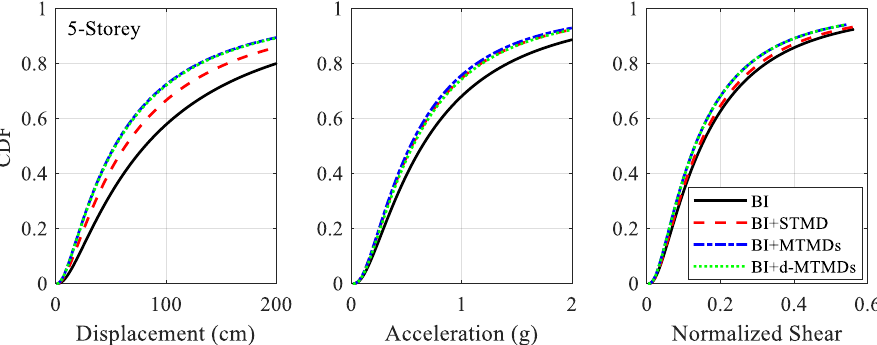
Figure 7. Cumulative probability distribution functions of maximum bearing displacement, peak top floor acceleration, and normalized shear force for 5-story building.